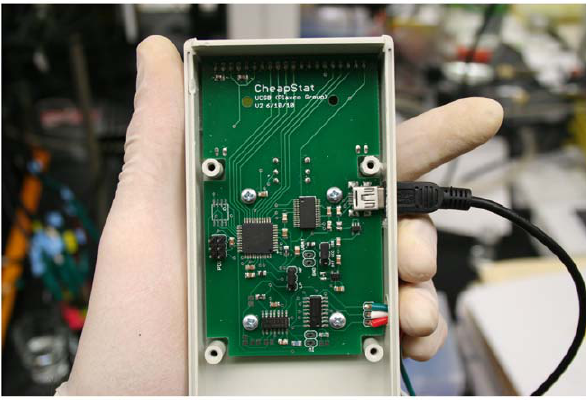
Figure 1. The CheapStat, an inexpensive, ‘‘do-it-yourself’’ potentiostat that can be built for under $ 80. The device supports cyclic, square wave, linear sweep and stripping voltammetry over the potential range 2 990to + 990 mV and over frequencies from 1 to 1000 Hz. The device supports a range of environmental, food and drug quality control, and educational applications. The reverse of the circuit board supports a three-line LCD display and a joystick, which is used to select an experiment protocol, change its parameters (frequency, starting voltage, end voltage, scan rate), and initiate the experiment. doi:10.1371/journal.pone.0023783.g001 PLoS ONE |